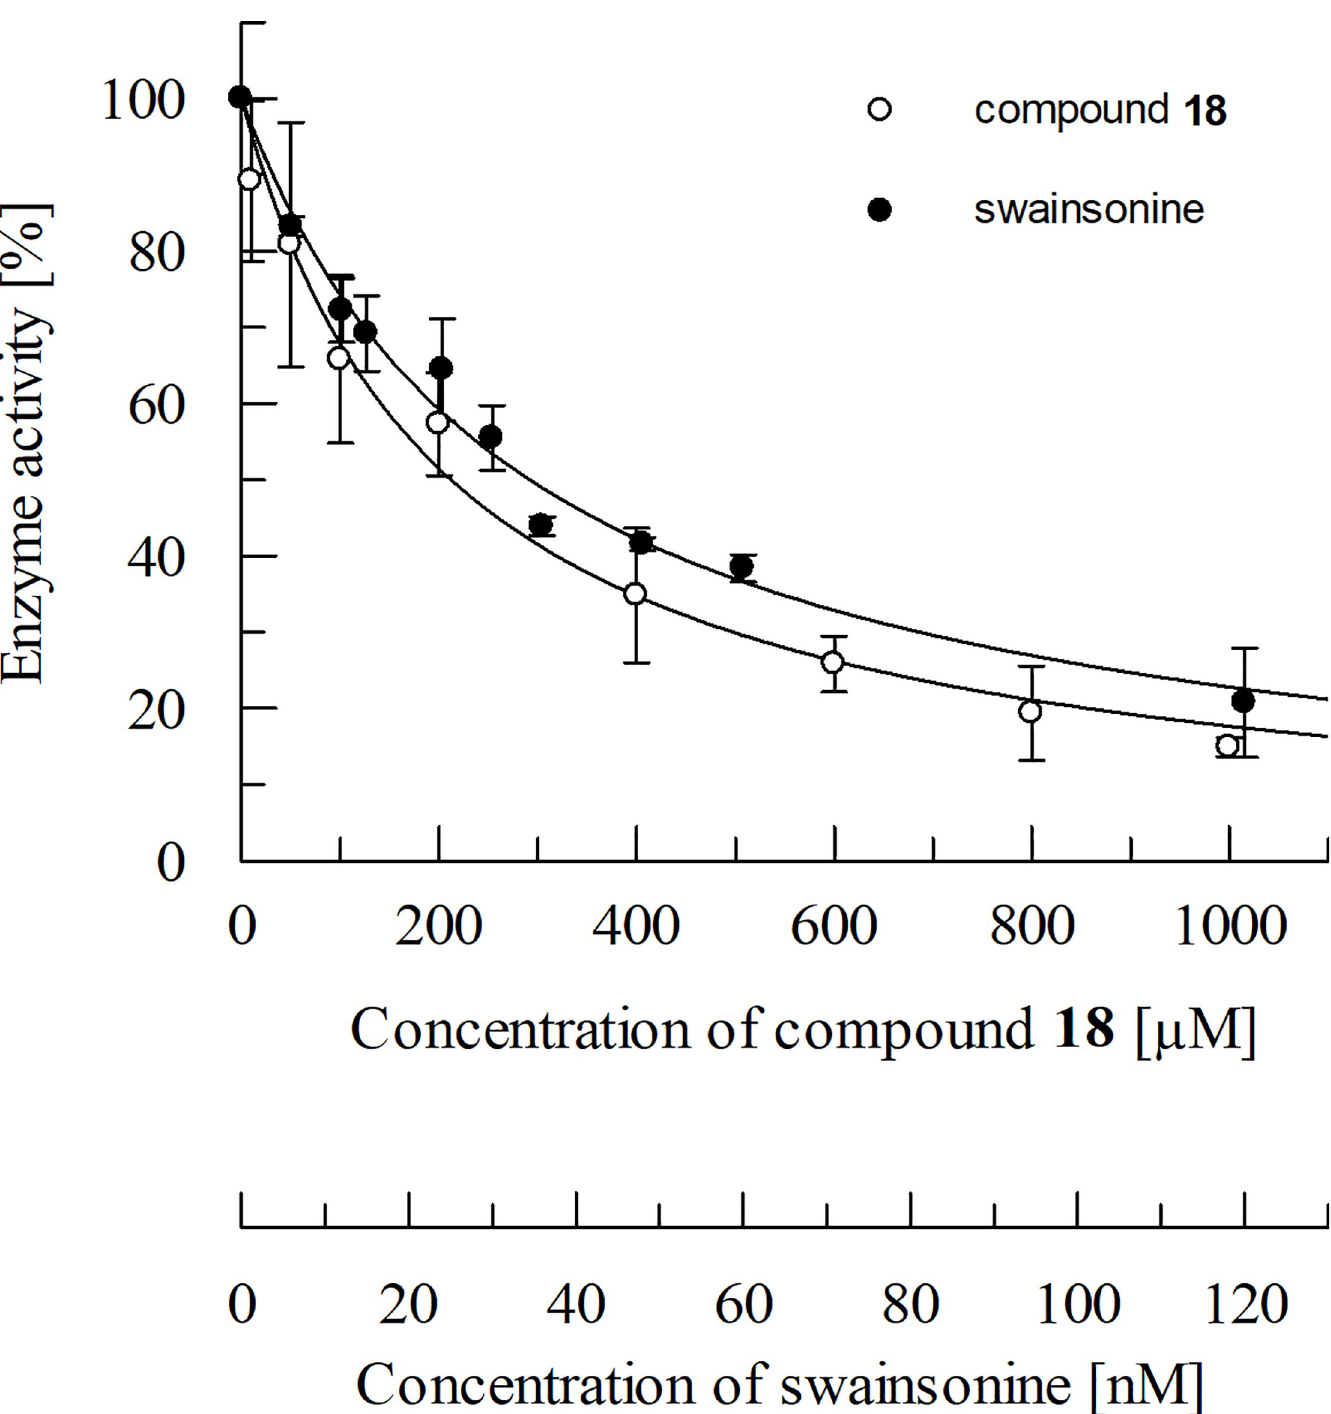
Fig 7. Example of an IC 50 curve of compound 18 and of swainsonine at a substrate (4-MU-Man) concentration of 1.5 mM. Non-linear regression was applied to the data using Eq (4).